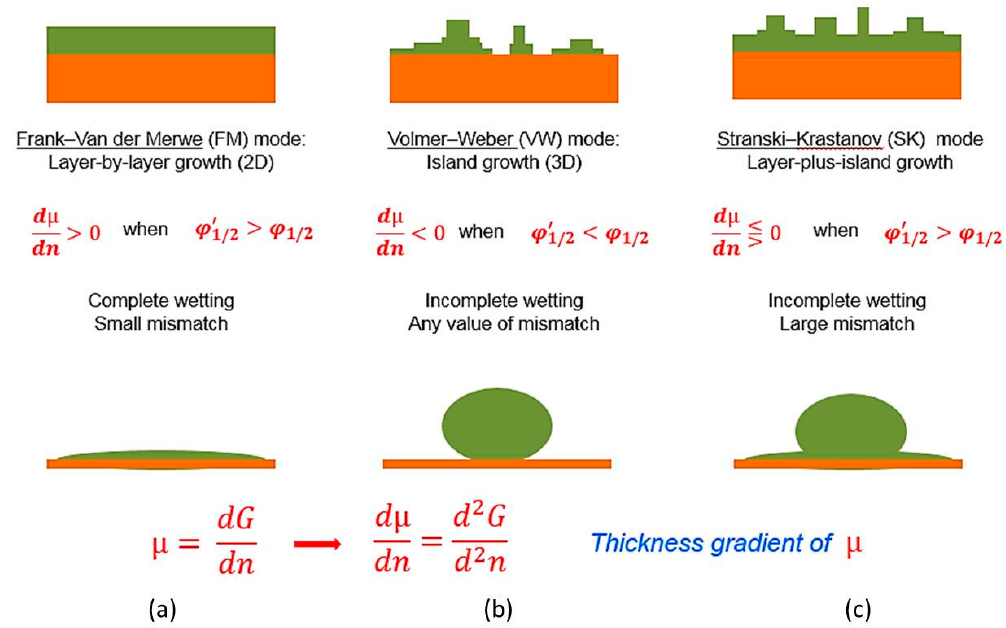
Figure 2. The three major modes of heteroepitaxy: ( a ) the 2D layer-by-layer growth called Frank–Van der Merwe (FM) mode; ( b ) the 3D island growth called Volmer–Weber (VW) mode; and ( c ) the layer-plus-island growth called Stranski–Krastanov (SK) mode.